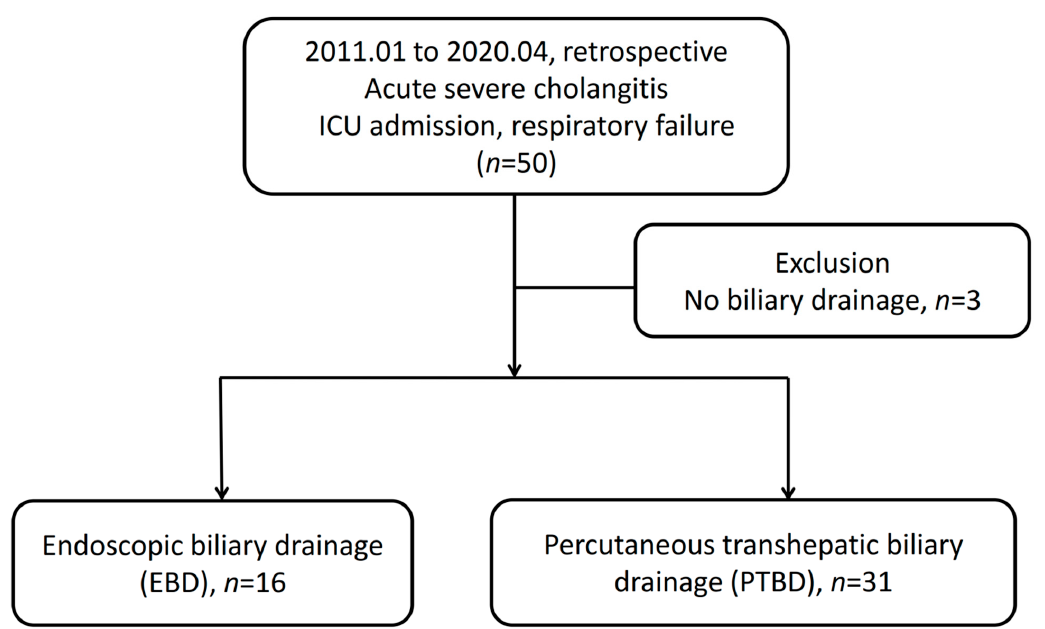
Figure 1. Flowchart of patients enrolled in this study. ICU, intensive care unit. Table 1. Baseline characteristics of study